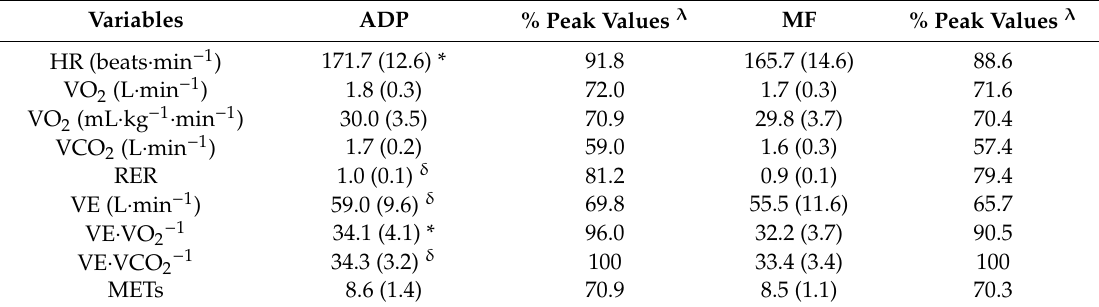
Table 2. Acute cardiorespiratory responses during both experimental